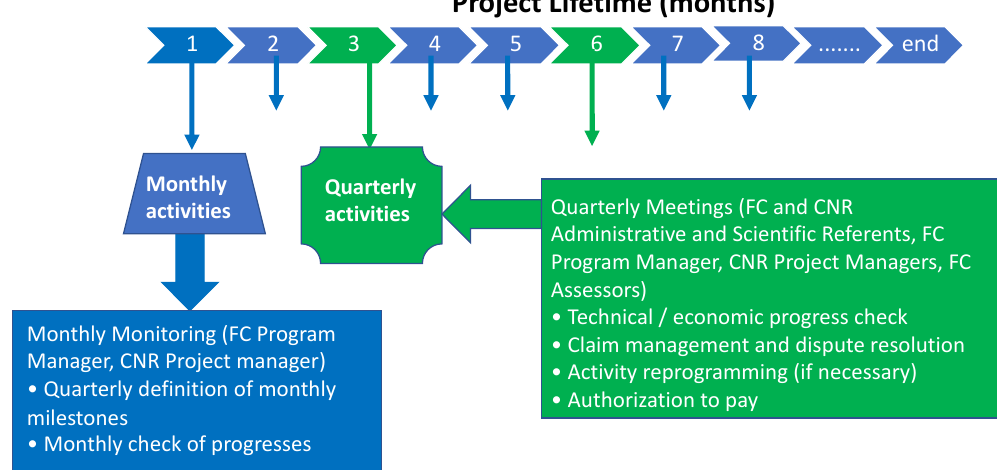
Figure 4. The monitoring and control actions (for each project).